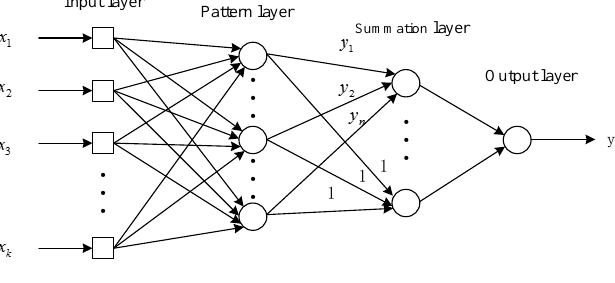
Figure 11. Structure of GRNN.